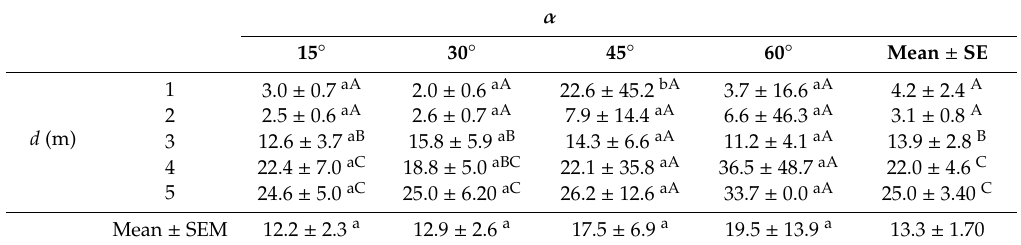
Table 4. MAPE of stem volume estimation for combinations of shooting distances and angular shifts.